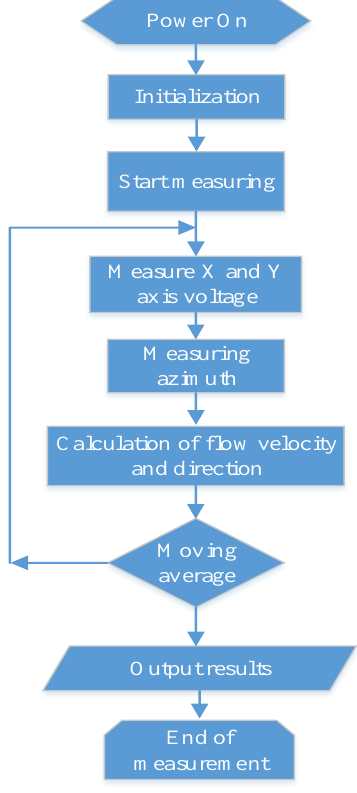
Figure 7. Flow chart of electromagnetic current measurement.